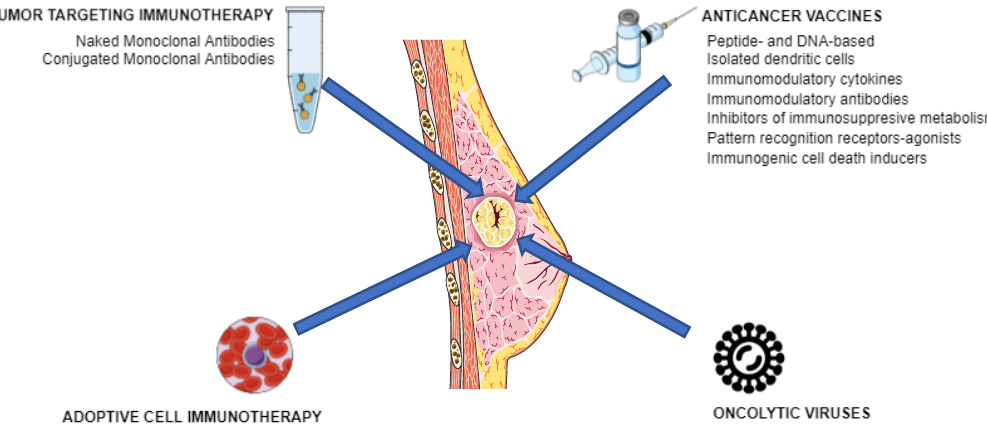
Figure 2. Modalities of cancer immunotherapy.